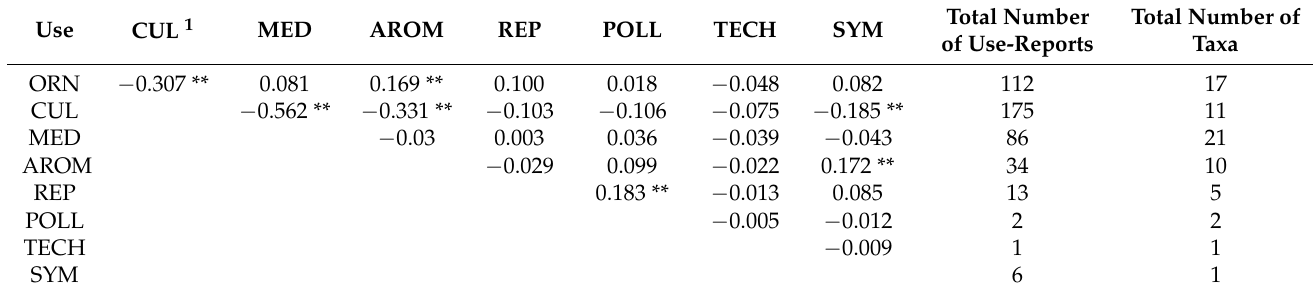
Table 3. Usage of Lamiaceae plants in rural Bulgaria and correlation between different usages.